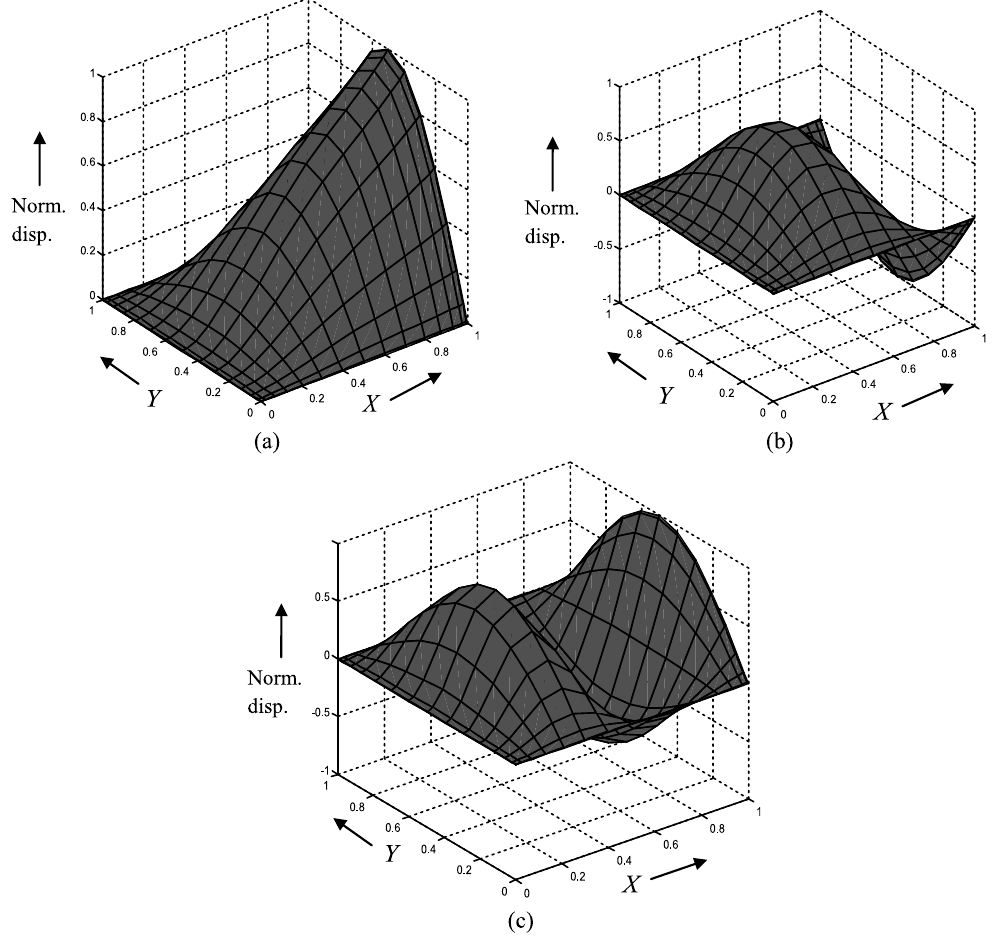
Fig. 12. Vibration modes of C-F plate (a) first mode (b) second mode (c) third mode; for a/b = 1 ,μ = β = 0 . 5 ,γ = 1 ,N ∗ 0 = 30